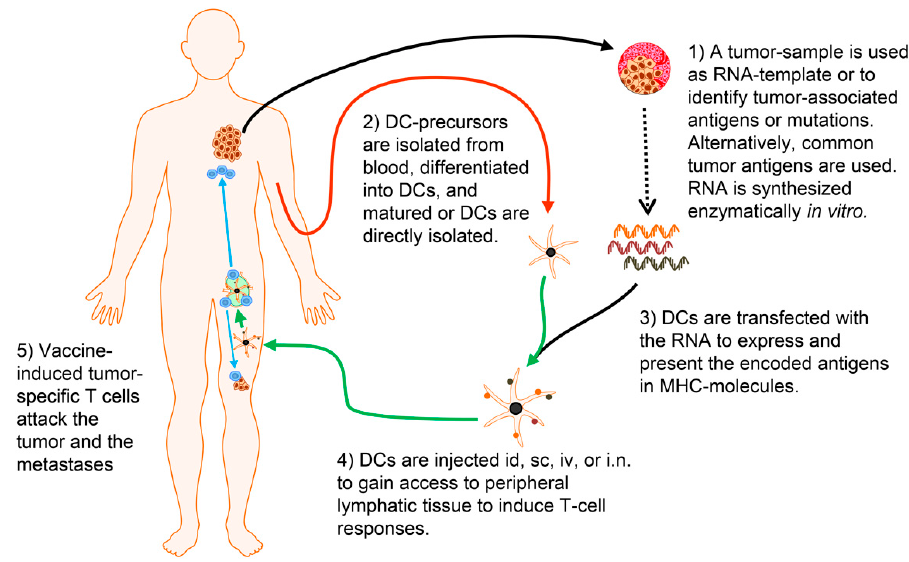
Figure 2. Concept of therapeutic vaccination with mRNA-transfected DCs. ( 1 ) Tumor material is isolated by surgery or biopsy. From this material, mRNA can be directly isolated. This RNA is usually amplified via a PCR-based method to gain sufficient amounts of mRNA. The tumor material can also be analyzed by sequencing, immunohistology, or other methods to identify antigens associated with this tumor, including somatic mutations. New bioinformatical methods can be used to identify the most promising T-cell epitopes for each individual patient. mRNA molecules that encode these antigens are transcribed in vitro from plasmid templates. ( 2 ) Cells (usually monocytes) that can be differentiated into DCs in vitro are isolated from the patient’s blood. Alternatively, DCs, which are present in the blood, can be used. These DCs are matured to become immunogenic. ( 3 ) DC are transfected with the RNA to express the encoded tumor antigens. The DCs’ own processing machinery degrades and presents the included T-cell epitopes in MHC. ( 4 ) The DCs are injected into the patient. Intradermal (id) and subcutaneous (sc) injection require migration via the lymphatic vessels towards the draining lymph node. Intravenous (iv) injection necessitates the transfer from the blood stream into lymphatic tissue. The direct injection into lymph nodes (i.n.) is an elegant approach, but is technically very difficult. ( 5 ) If the vaccine is successful, the DCs present the tumor-specific epitopes to T cells which are activated and attack the malignant tissue. Usually the DCs are injected repetitively to boost and maintain the responses. (The Motifolio Scientific Illustration Toolkit was used for the generation of this figure).